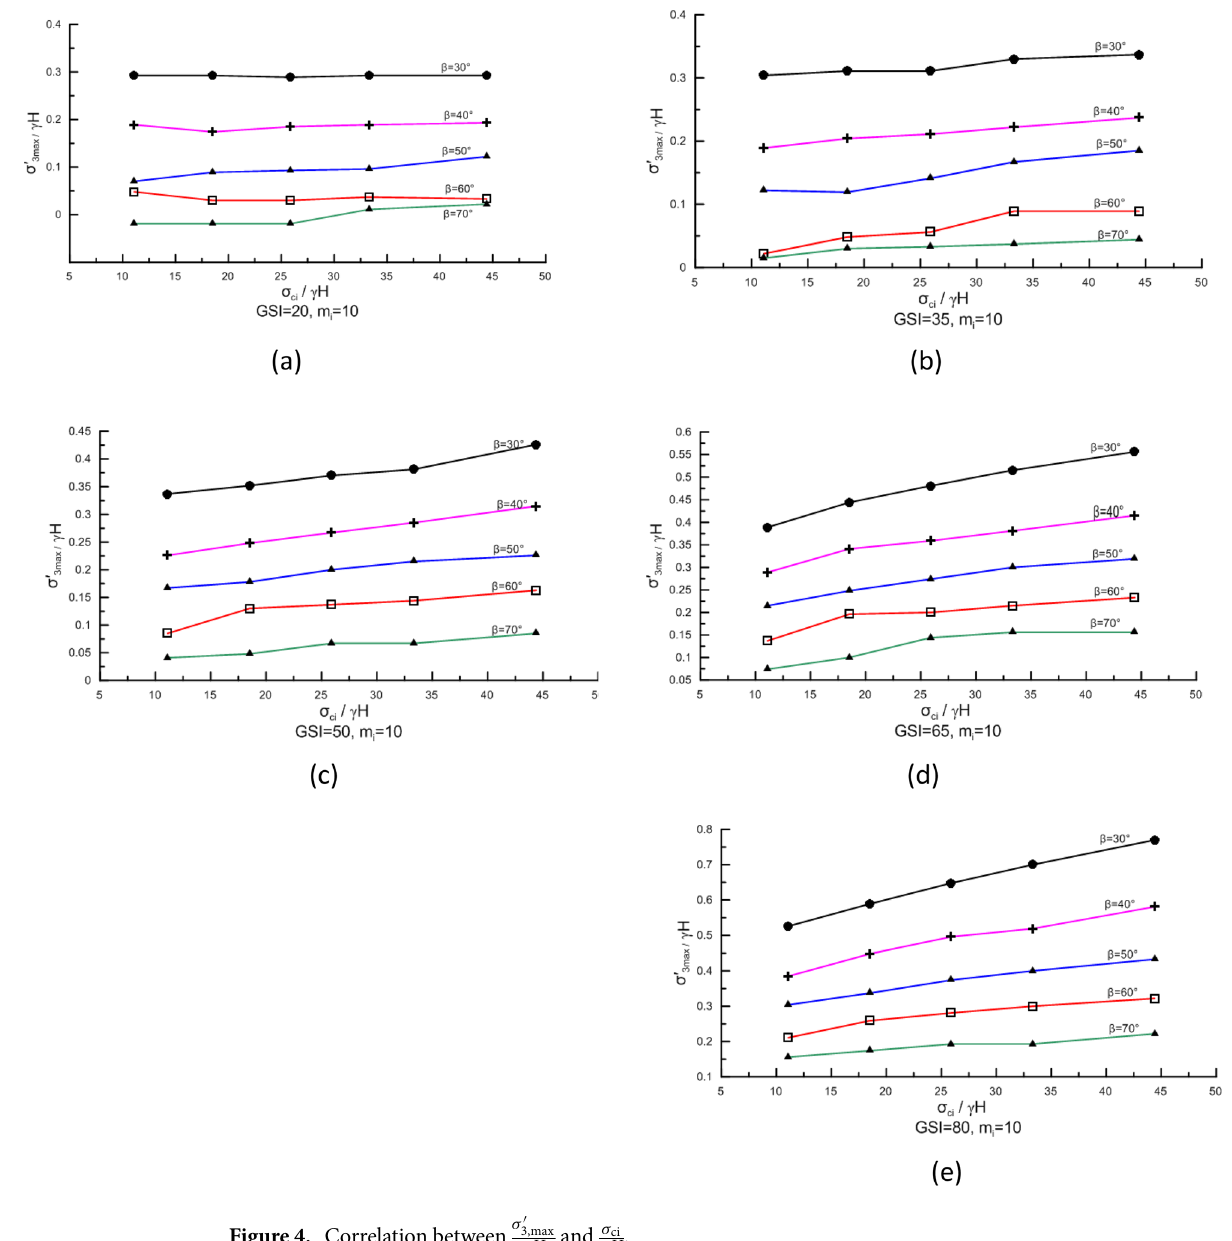
Figure 4. Correlation between